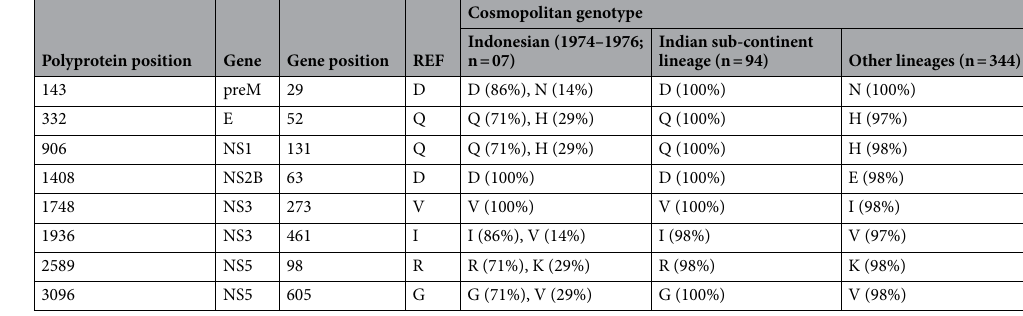
Table 5. Unique amino acid substitutions shared between the Indian sub-continent lineage and Indonesian sequences (1974–1976). Percentage values indicate the extent of fixation of each mutation in respective groups of sequences. NCBI reference sequence NC_001474.2 was used as the reference (REF) genome. NS non- structural proteins, preM pre-membrane.